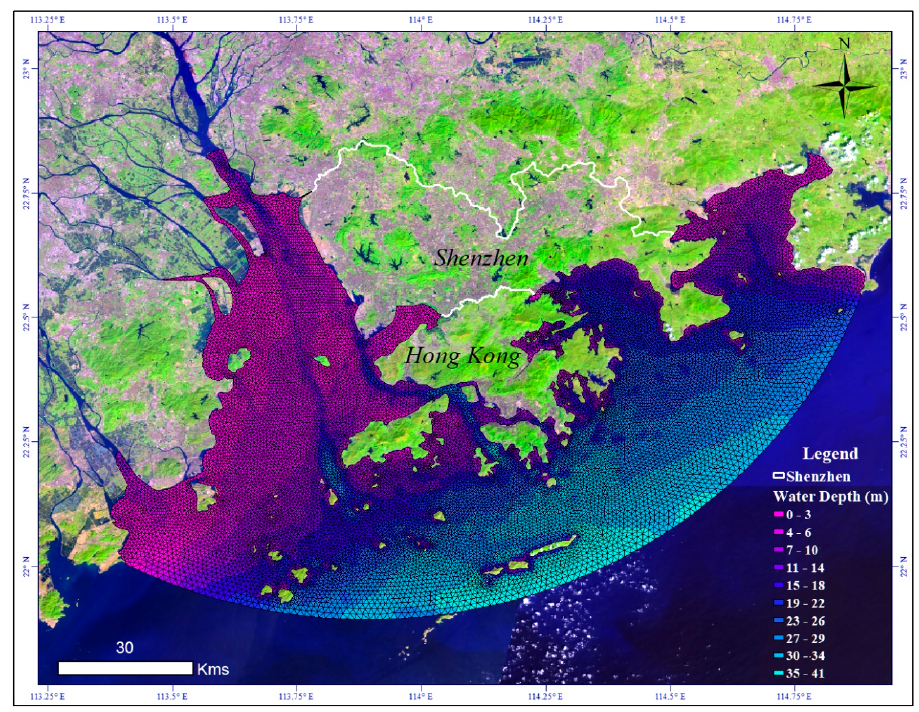
Figure 3. The modeling domain and discretized grids for the numerical model.